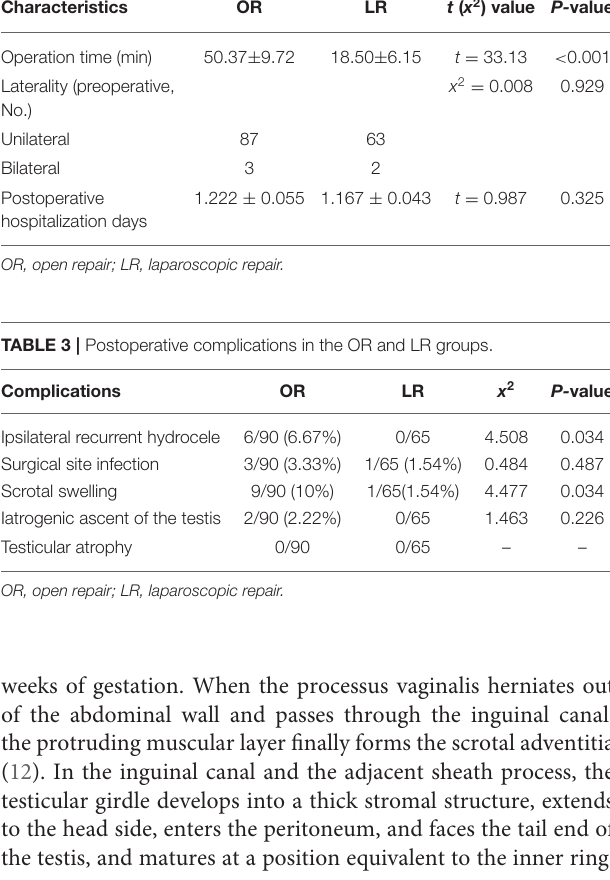
TABLE 2 | Comparison of operation site, operation time, and postoperative hospitalization time between the two groups. Characteristics